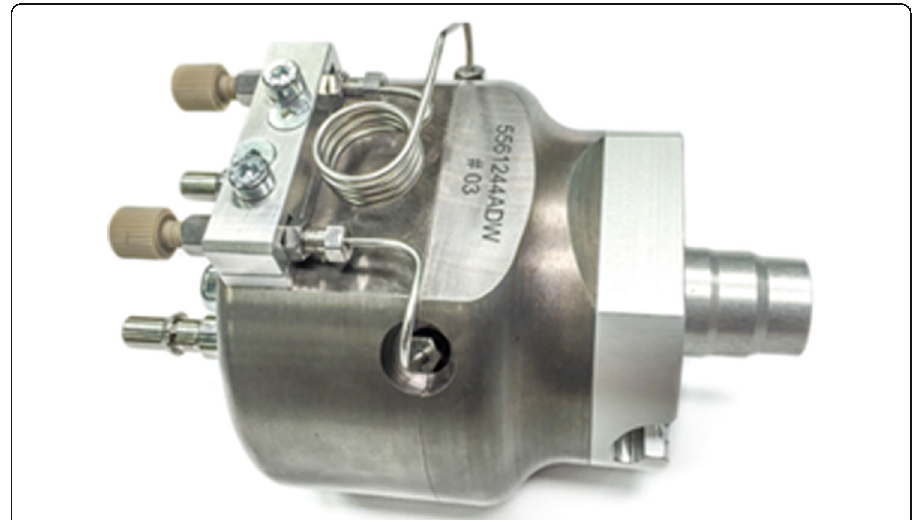
Fig. 3 Self-shielded high yielding niobium target for production of fluorine-18 (image courtesy of GE